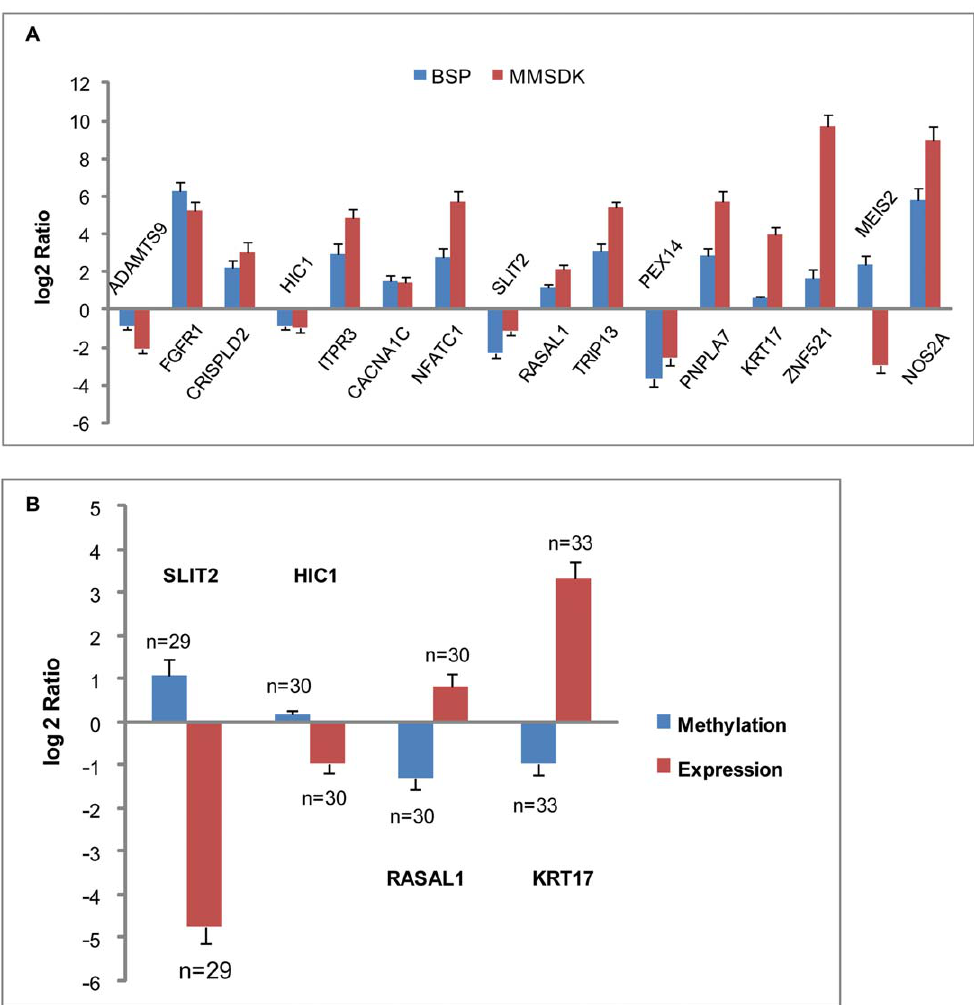
Figure 2. Validation results of BSP for DNA methylation and RT-qPCR for gene expression. A. Validation results of MMSDK with BSP. To compare the BSP-Sanger sequencing data and deep sequencing MMSDK data, the MluI loci that were determined to be differentially methylated on average by deep sequencing were validated using BSP. The height of the columns represents the log2-transformed average fold change (tumor/ normal) in methylation level across the 9 patients. B. BSP and RT-qPCR results for four cancer-associated genes examined in 33 bladder cancer patients. The methylation levels of promoters of four selected genes (SLIT2, HIC1, RASRAl1, KRT17) and their expression level were evaluated in a panel of 33 samples. The height of the columns represents the log2 average fold change (tumor/normal) in methylation level (blue) or expression level (red) across all patients. The bars represent the standard error. The number of samples (n) used in the validation assay is indicated beside each standard error bar.